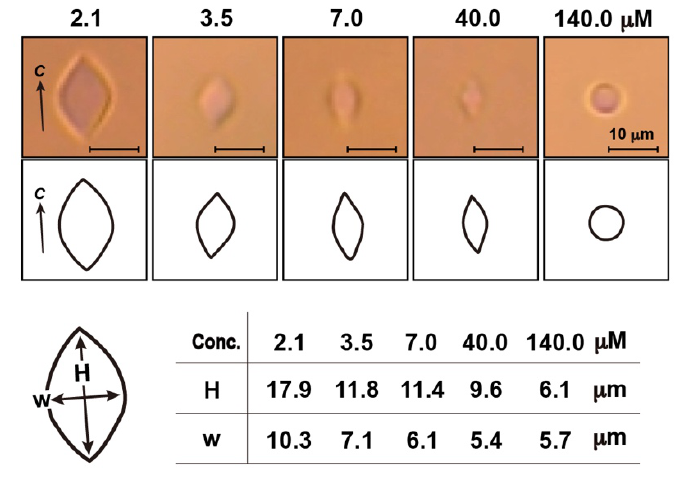
Figure 4. Change in the photomicroscopic image of a single ice crystal with the increase in concentration of AFP II, in which scale bars represent 10 µm. Illustrated interpretations are indicated for each small image whose edge is hardly detected. The crystallographic c -axis of the lemon-shaped crystal is indicated in the left panel. For concentrations 2.1, 3.5, 7.0, 40.0, and 140.0 µM of AFP II, the corresponding aspect ratio (W/H) is 0.58, 0.60, 0.54, 0.56, and 0.94, respectively.